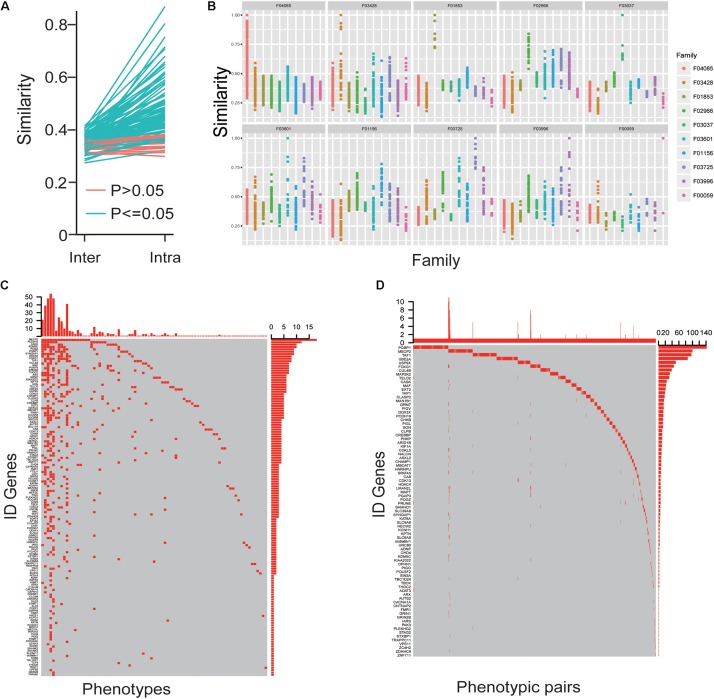
The convergences of ID phenotypes. (A) The mean value of intra-similarity between patients caused by one gene was higher than the mean value of inter-similarity between the gene’s patients and other genes’ patients. (B) The similarity of phenotypes in patients caused by identical mutations among the same and other families. (C) The oncoprint-like representation of specific phenotypes for genes. (D) The oncoprint-like representation of specific phenotypic pairs for genes.